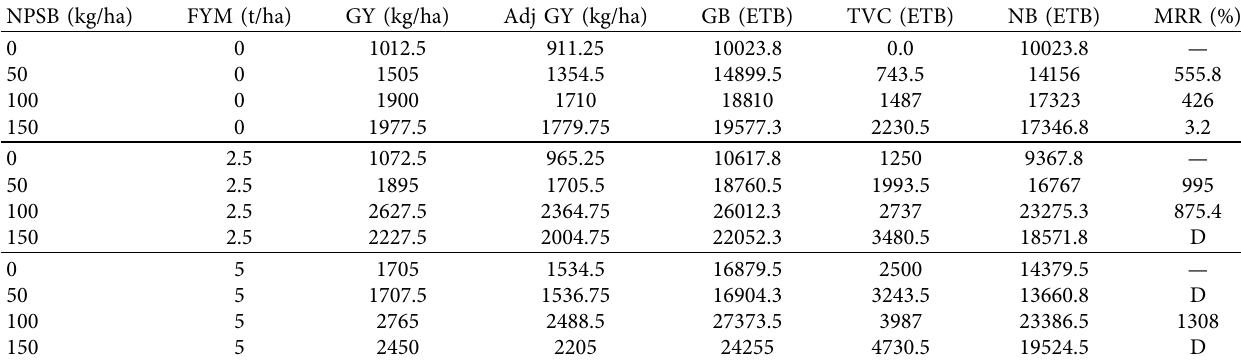
Table 9: Proftability as afected by NPSB and FYM fertilizer